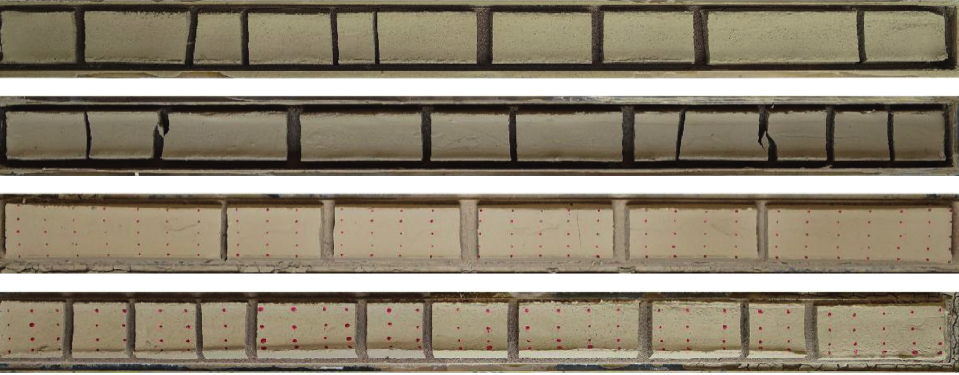
Figure 10: The final crack